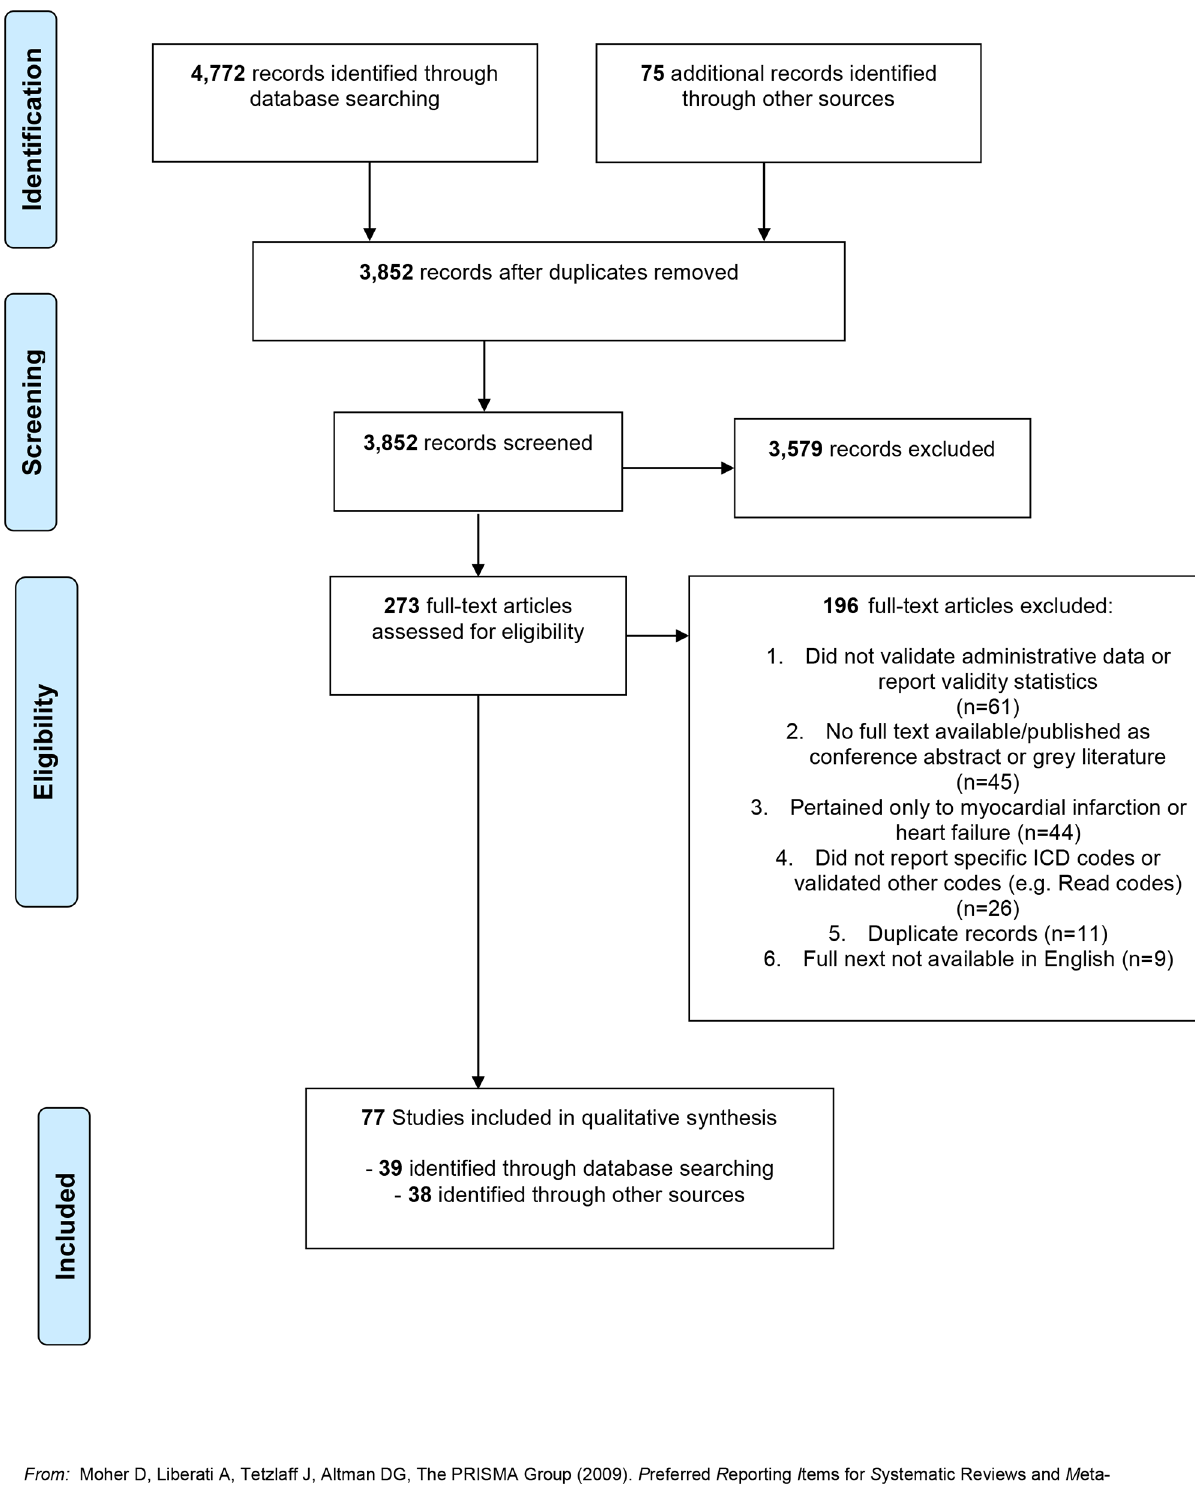
Fig 1. Preferred Reporting Items for Systematic Reviews and Meta-Analyses (PRISMA)-style Flowchart of Study Selection and Review. ICD = International Classification of Diseases. doi:10.1371/journal.pone.0135834.g001 PLOS ONE | DOI:10.1371/journal.pone.0135834 August 20,